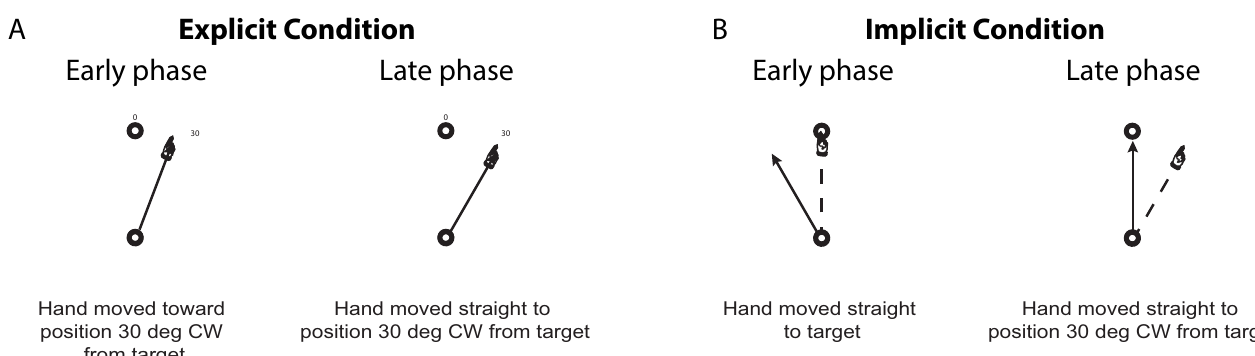
targetHand moved straight to Hand moved straight Hand moved straight to position 30 deg CW from target to position 30 deg CW from target Fig 3. Experimental conditions. (A) In explicit condition, subjects were instructed to reach toward imaginary targets that were rotated 30 degrees CW about start circle from targets that appeared on outer circle. In early phase (left panel), subjects reached toward a position between visual and imaginary targets; in late phase (right panel), they reached accurately to imaginary target. Solid black lines with hand sign at the end indicate both cursor and hand movement directions. (B) In implicit condition, subjects were instructed to reach towards visual targets without knowing that the cursor was rotated 30 degrees CCW about the start circle. In early phase (left panel), subjects reached straight toward the target, while the cursor moved 30 degrees CCW from the target; in late phase (right panel), subjects moved the hand straight toward the positions that were rotated 30 degrees CW from the targets, which brought the cursor straight to the targets. Solid black arrows indicate cursor movement directions; solid black lines with hand sign at the end indicate hand movement directions.